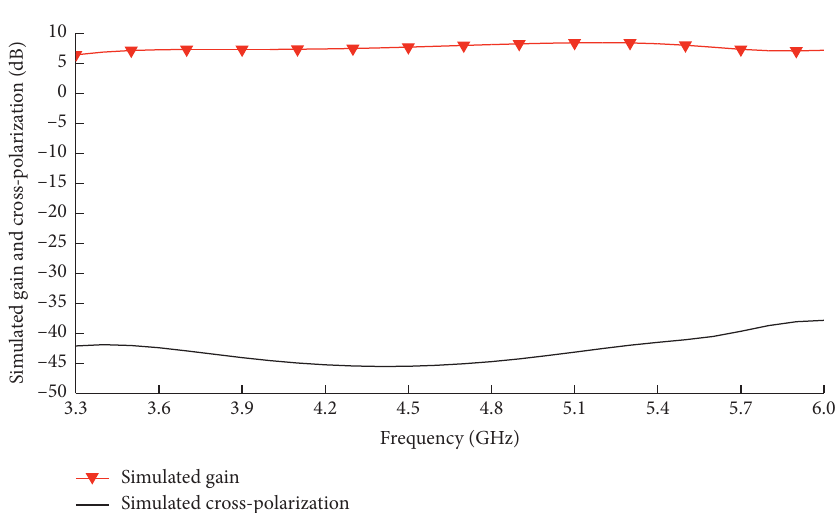
Figure 8: Simulated gain and cross-polarization of the antenna at the broadside